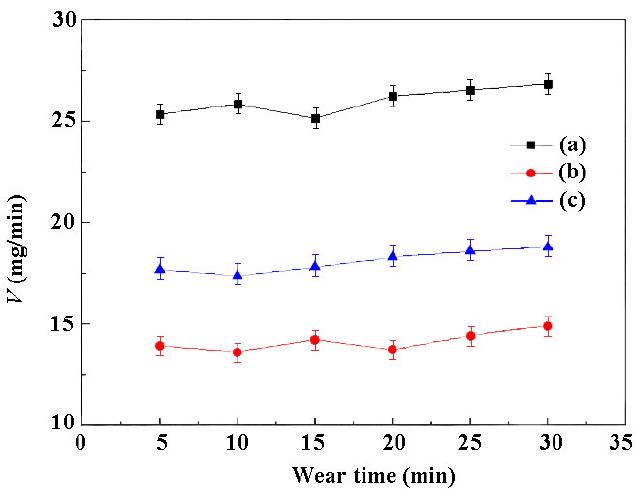
Figure 8. Wear rates of Ni/TiN-SiC nanocomposites generated with diverse pulse current densities: ( a ) 2 A/dm 2 , ( b ) 4 A/dm 2 , and ( c ) 6 A/dm 2 .